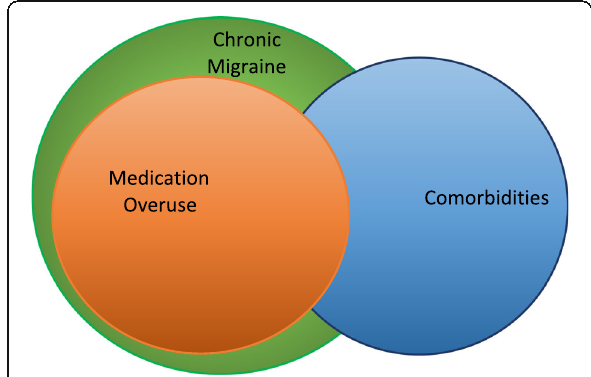
Fig. 1 Putative overlapping of Chronic Migraine, Medication Overuse and Migraine